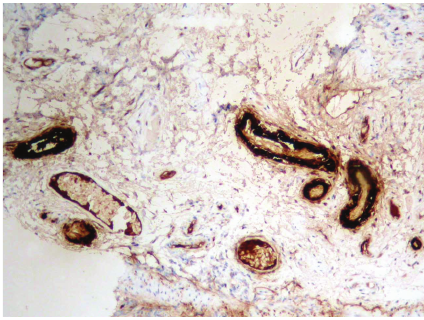
Figure 4: Immunolabeling pattern with monoclonal anti-amyloid A antibody (mc1